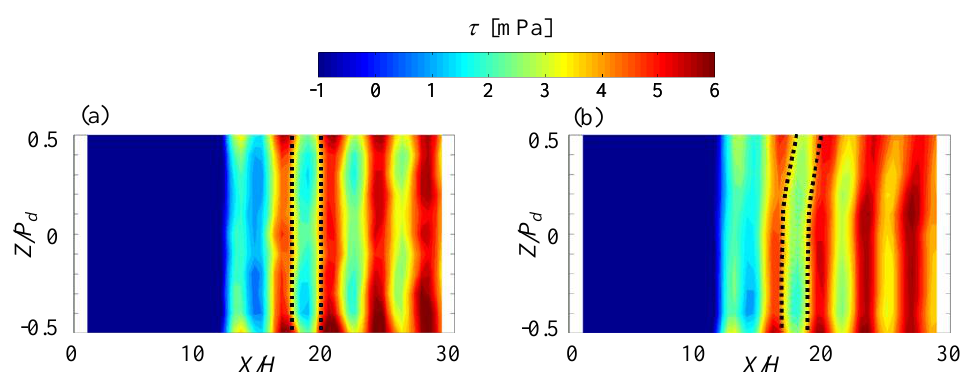
Fig. 8 Wall shear stress distribution in Re = 300 and F